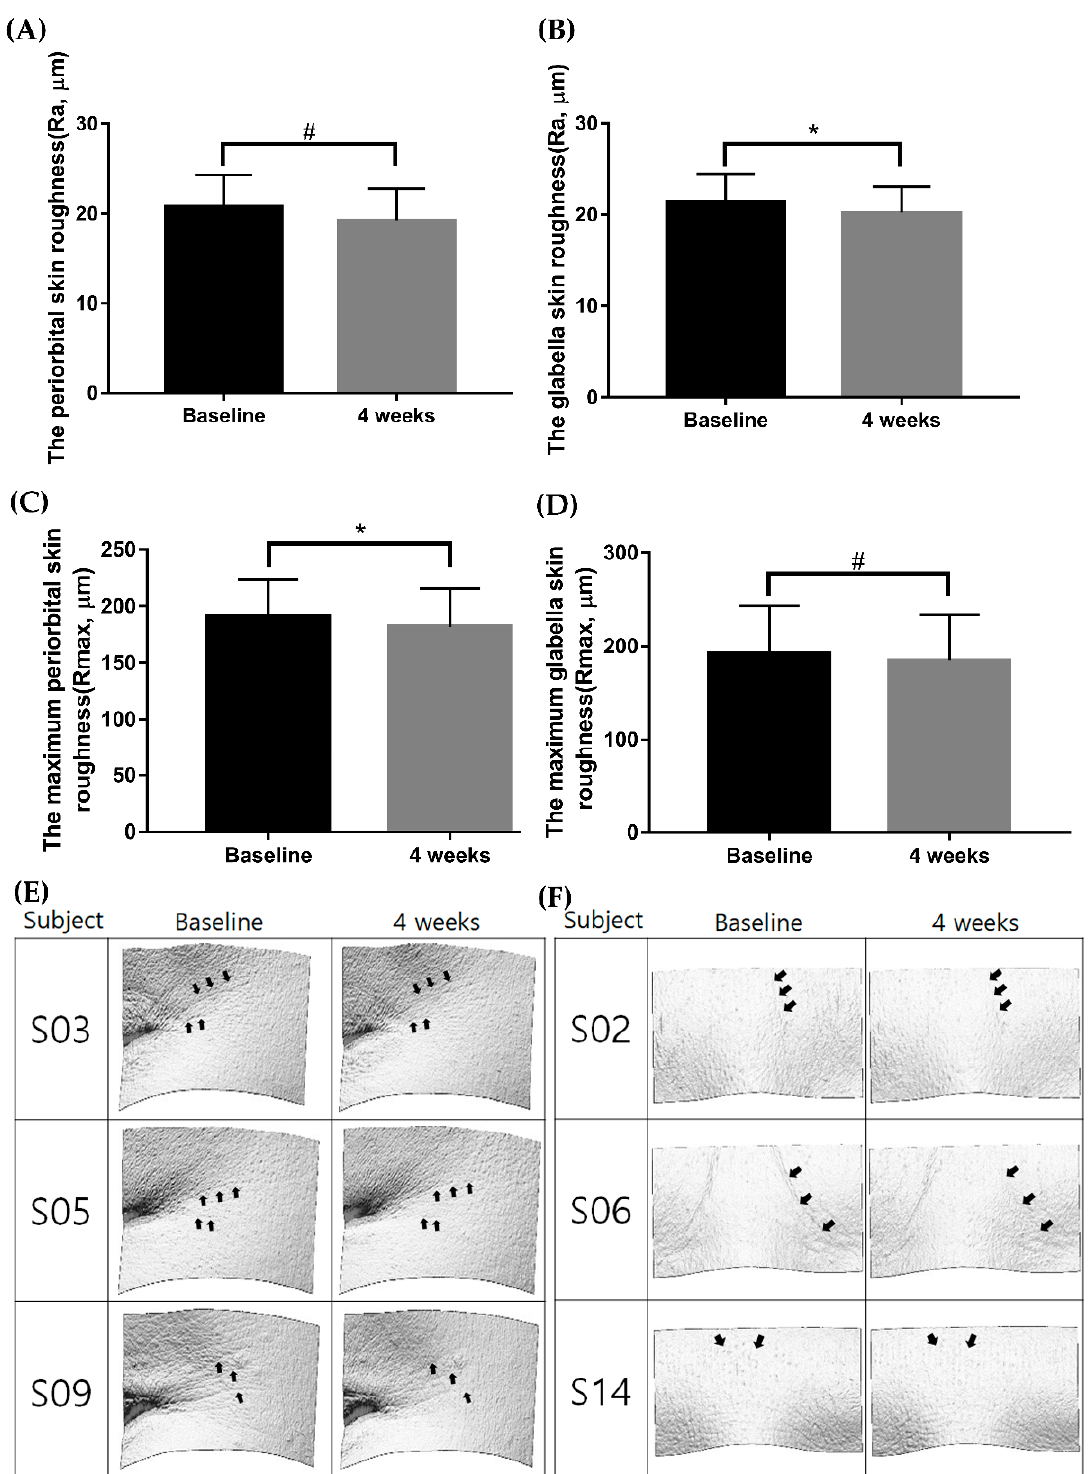
Figure 1. Comparison of skin roughness and maximum skin roughness before and after 4 weeks of applying the CTP ampoule. Skin roughness and maximum skin roughness were reduced in response to application of the CTP ampoule over 4 weeks ( A – D ); # p < 0.001, Wilcoxon signed-rank test; * p < 0.001, paired samples t -test). The 4 week follow-up images taken with PRIMOS (PRIMOS CR, SnT Lab, Seoul, Korea) are shown in ( E , F ). CTP ampoule, Ever Collagen Corrector Collagen Tripeptide Ampoule.